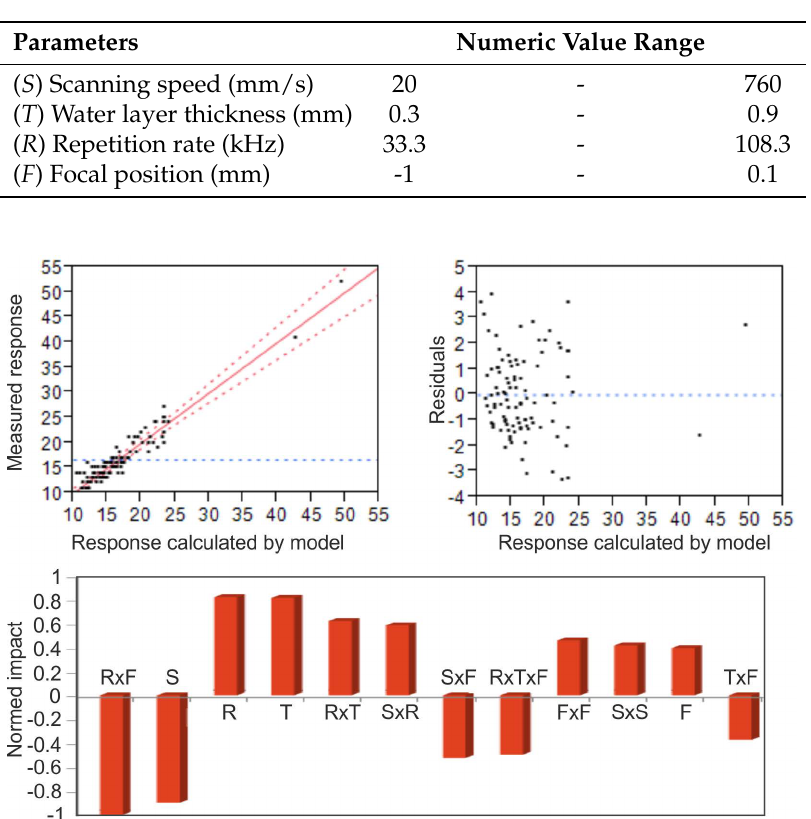
Figure 4. Fit statistics. Measured points relative to model-calculated points are displayed in the top left corner. Deviations (residuals) of the actual points from the calculated points are displayed in the top right corner. Coefficient data and their impact on the results are displayed in the bottom part. Fit